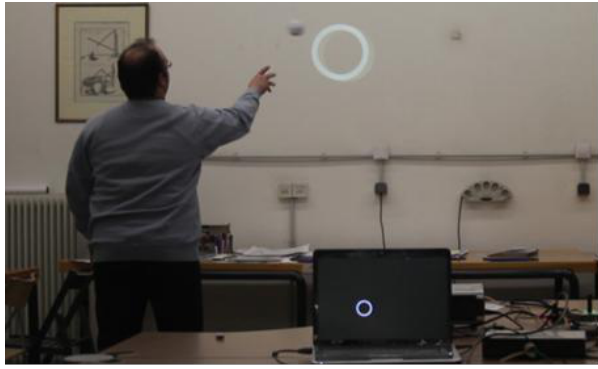
Figure 10. Throwing real paper ball at virtual targets